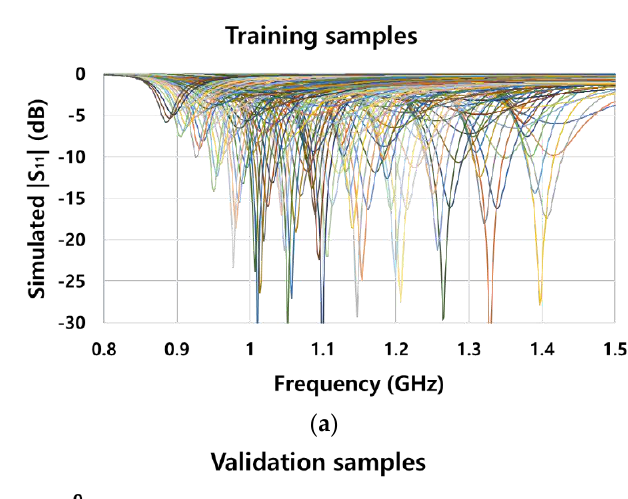
Figure 4. Magnitude of input impedance S 11 for ( a ) all training and ( b ) all validation samples according to the combination of series capacitor C S and parallel capacitor C P . Table 1. Capacitor values in matching circuit for training.